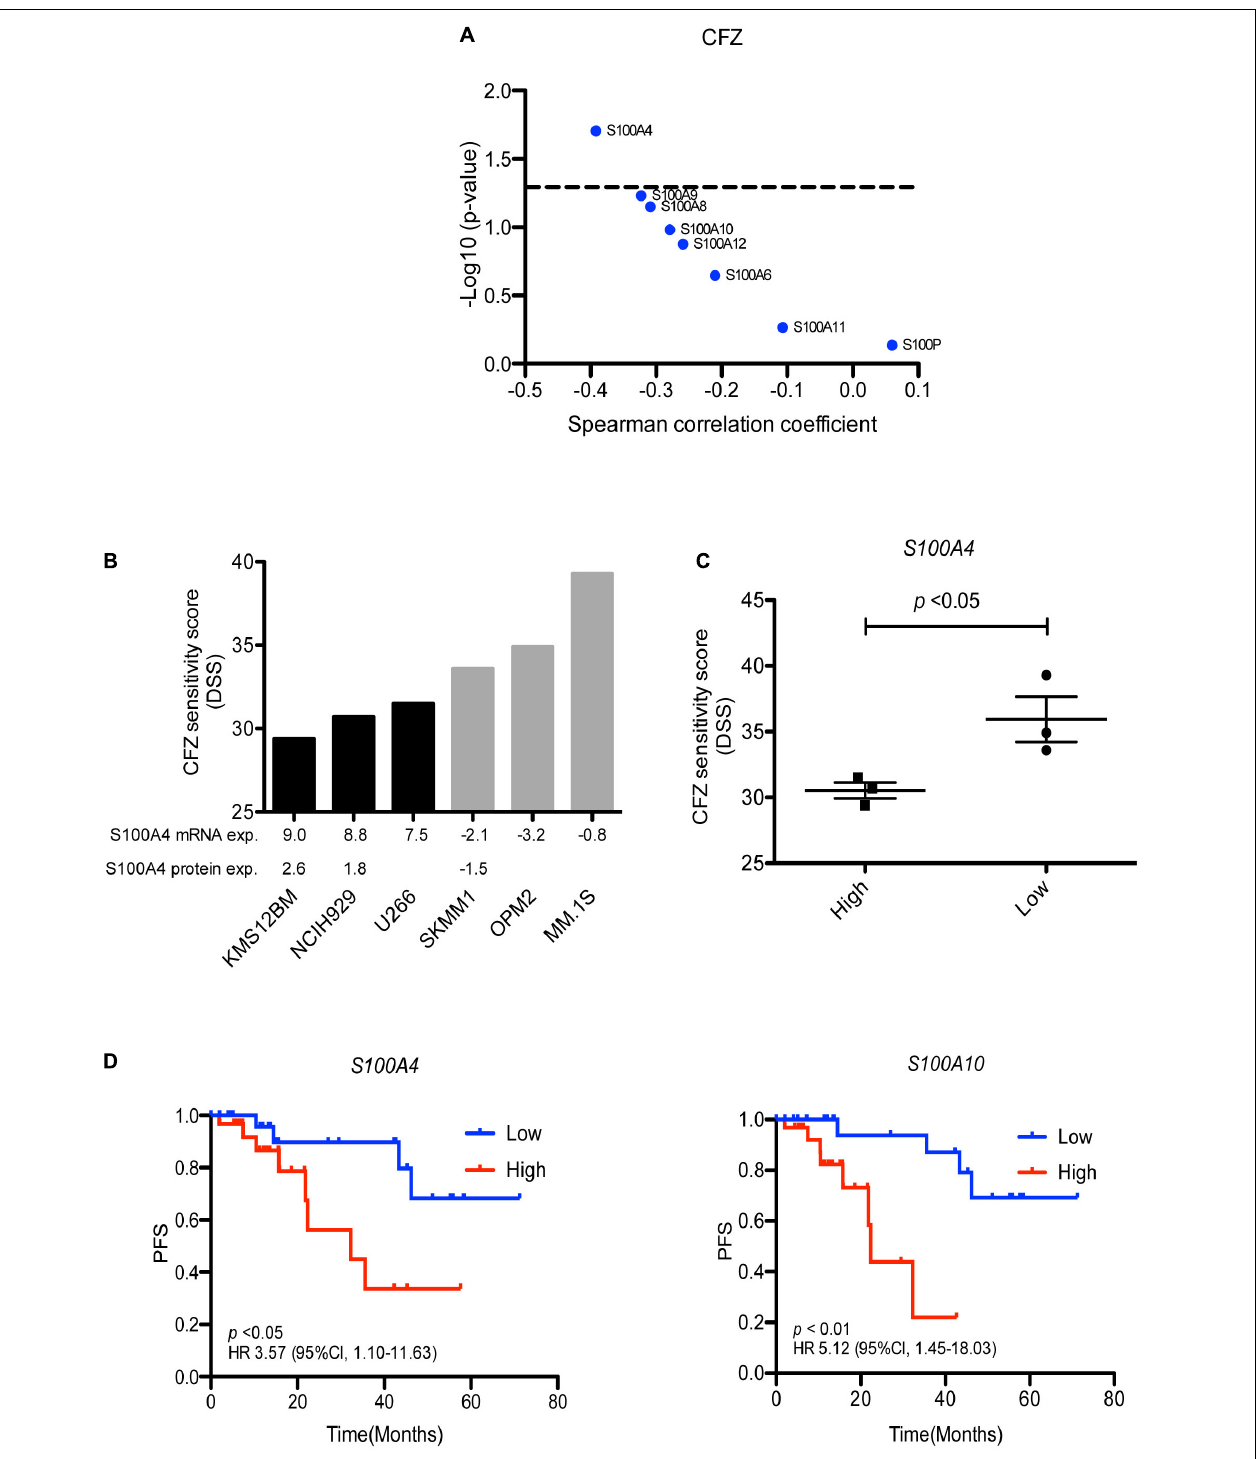
FIGURE 5 | S100A4 overexpression linked to carfilzomib resistance. (A) Correlation of S100 protein expression with ex vivo carfilzomib sensitivity. (B) CFZ score in the MM cell lines having high and low–level expression of S100A4. Gene and protein expression presented as log 2 FPKM value and log 2 LFQ intensity, respectively. (C) Statically analysis of CFZ DSS value in the MM cell lines expressing high vs. low expression. (D) High expression of S100A4 and S100A10 correlated with shorter progression free survival in 63 MM patients, who received first-line carfilzomib-based therapy from the CoMMpass dataset. Low and high are defined as expression below and above the median value. CFZ, carfilzomib; DSS, drug sensitivity score; PFS, progression free survival.